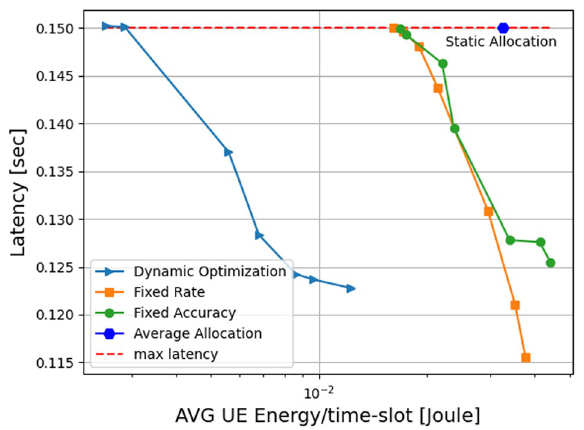
Fig. 7 Latency/energy trade-off for static and dynamic resource allocation strategies. A avg = 2 DU / slot . This figure compares the trade-off between latency and accuracy considering our fully dynamic optimization strategy, with static resources allocation strategy, where learning, transmission and computation capabilities are kept